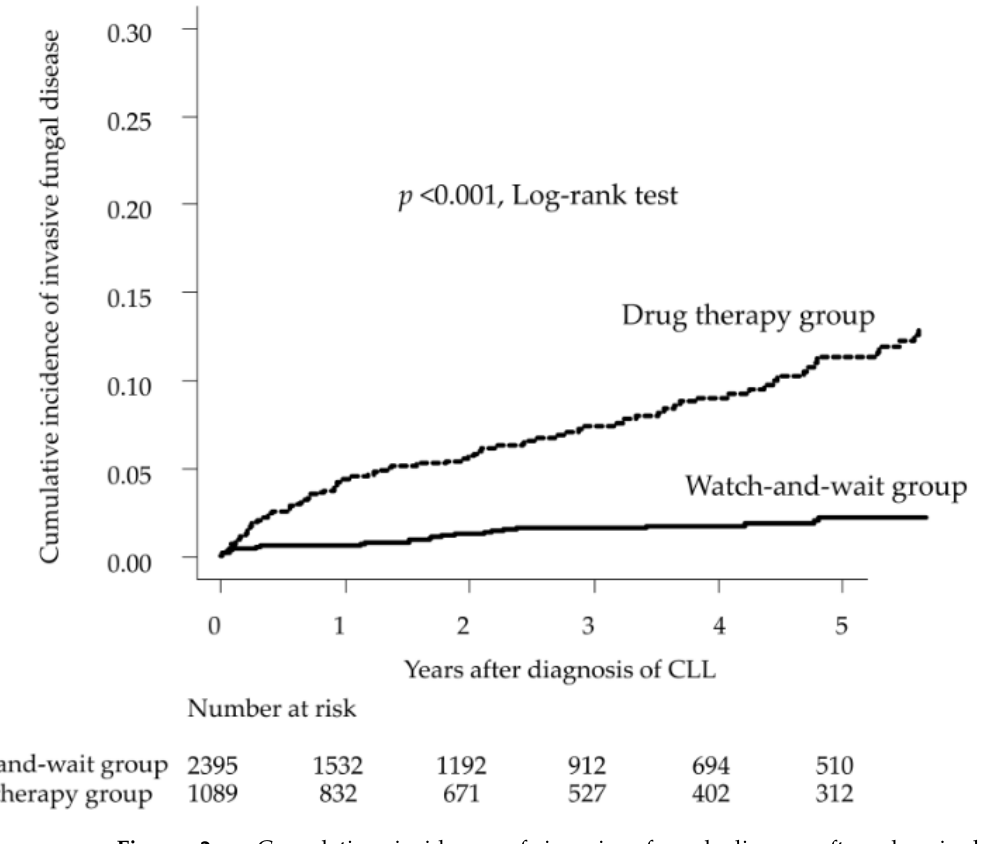
Figure 2. Cumulative incidence of invasive fungal disease after chronic lymphocytic leukemia diagnosis. Table 2. Characteristics of invasive fungal diseases.